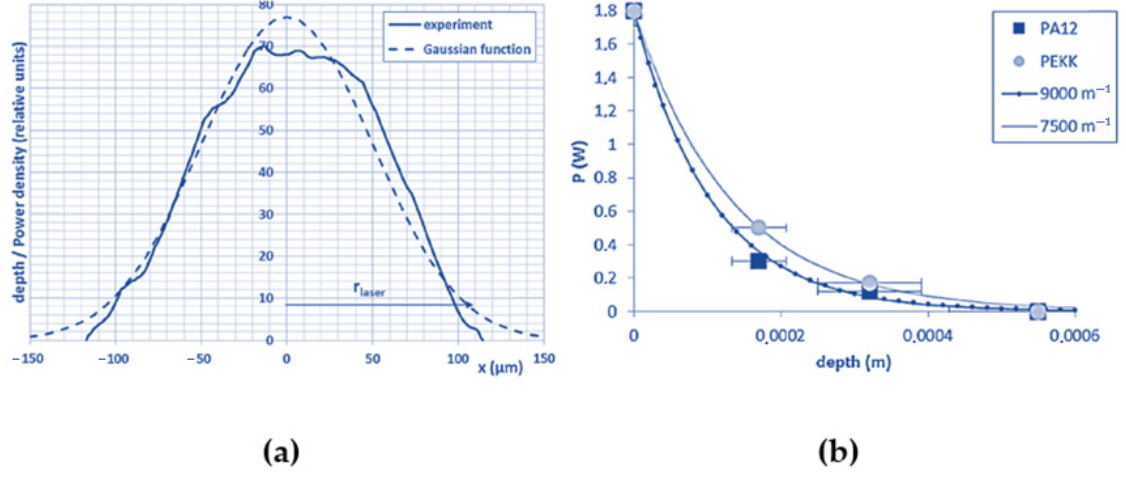
Figure 12. ( a ) The 2D beam profile distribution of the laser; ( b ) laser/power transmission measure- ments. Adapted from [67].